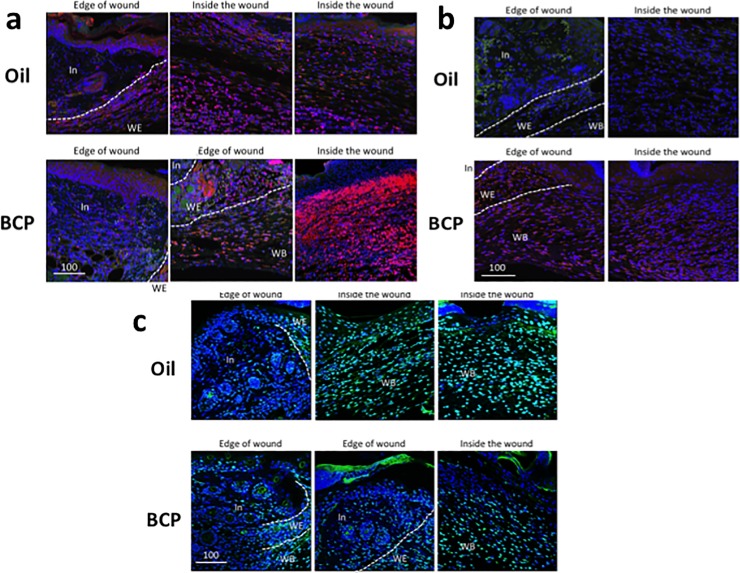
IL-1β, TNFα in the skin at the wound bed and close to the wound, and TUNEL staining of the skin at the wound bed and close to the wound.(a) IL-1β (red and purple) expression in the BCP and the Oil group. Blue color as well as purple color is Draq 5+ cells. Green is autofluorescence. (b) TNFα expression (red and purple) expression in the BCP and Oil group. Blue color as well as purple color is Draq 5+ cells. Green is autofluorescence. (c) TUNEL staining with double staining with Draq 5. Green and light blue is TUNEL+ cells. Blue and light blue is Draq5+ cells. Scale bars are μm.